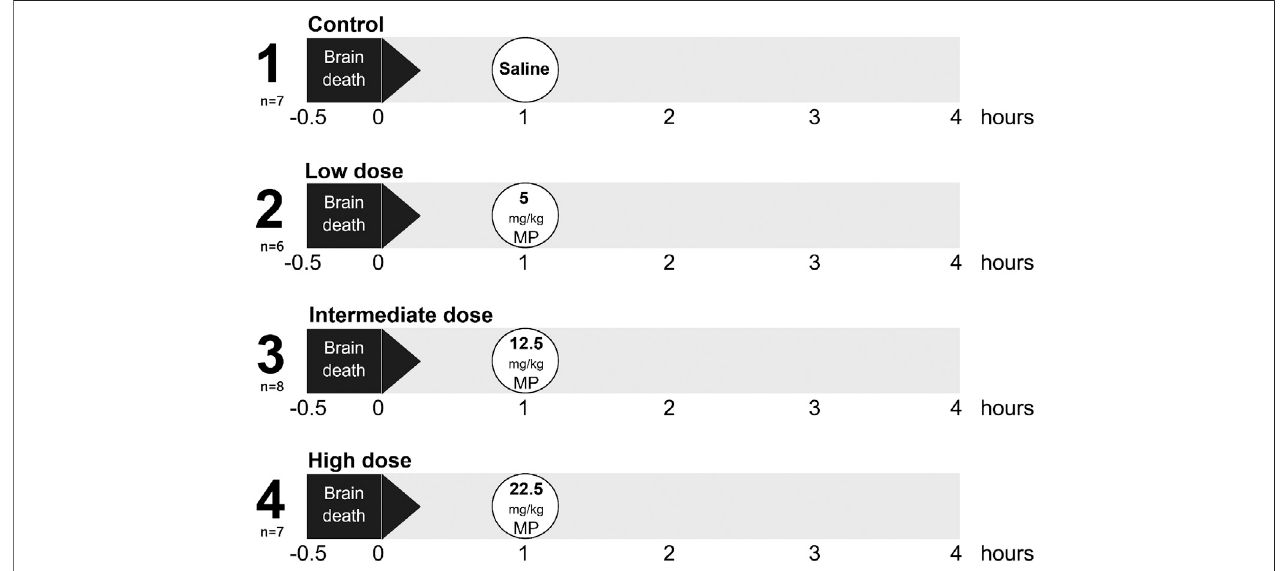
FIGURE 1 | Experimental outline of the study. Rats were randomly assigned to one of four experimental groups, each consisting of 6-8 rats. Brain death (BD) was induced in all experimental groups, and 1 h after BD induction rats were treated intravenously with 1) 0.9% saline (control, n (cid:1) 7), 2) low dose methylprednisolone (MP, 5 mg/kgofbodyweight(BW),n (cid:1) 6),3)intermediatedosemethylprednisolone(12.5 mg/kgofBW,n (cid:1) 8)and4)highdosemethylprednisolone(22.5 mg/kgofBW,n (cid:1) 7).